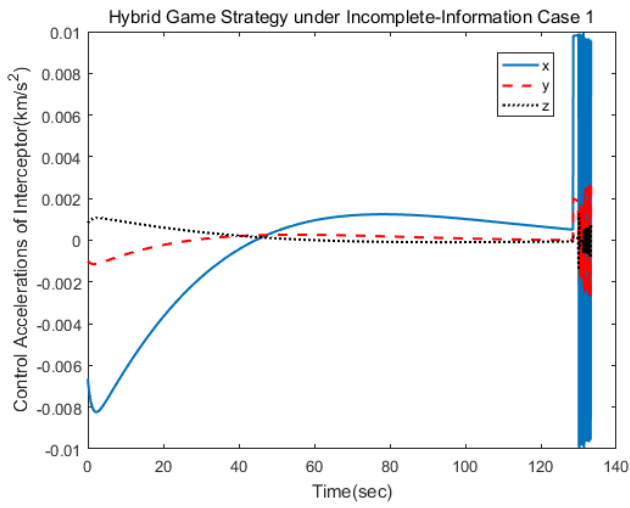
Figure 4. Relative distance between the pursuer and the target.